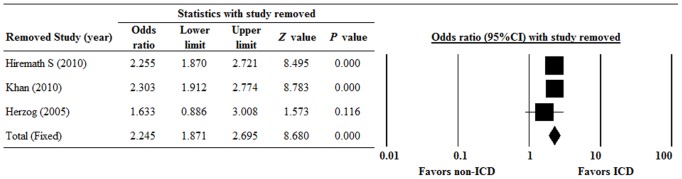
Sensitivity analysis for the influence of individual studies on pooled estimates by the leave-one-out approach for overall survival (OS).Data are presented as odds ratio (OR) with the 95% confidence interval (CI). P<0.05 indicates a statistically significant difference.